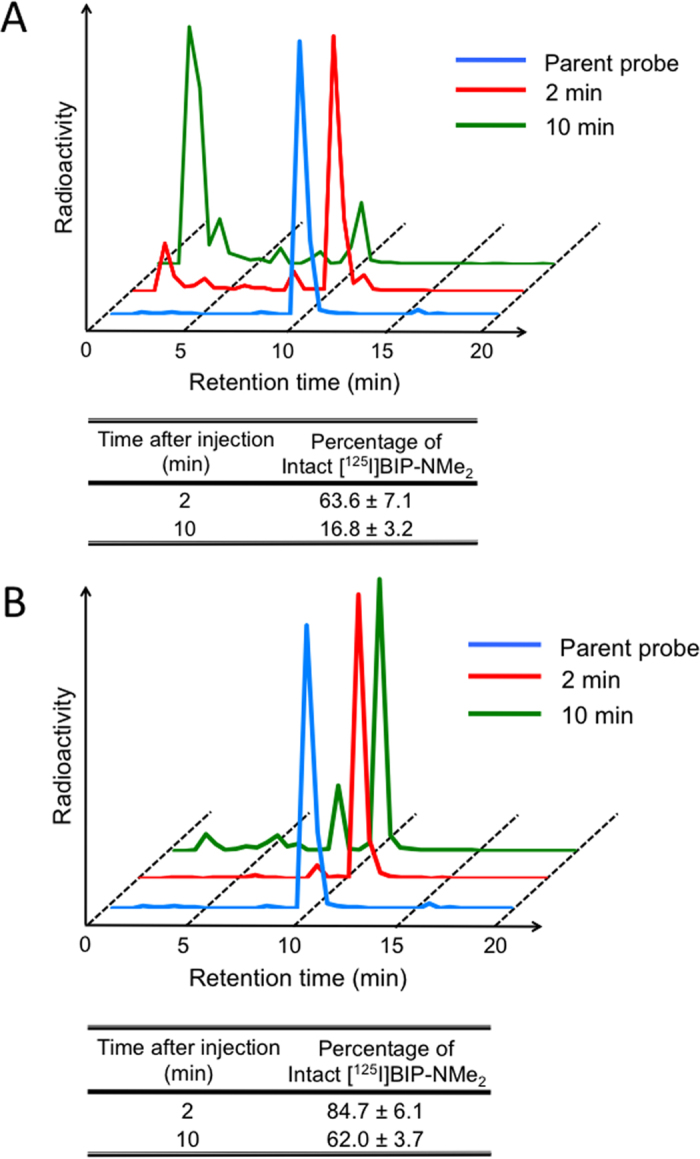
HPLC analysis of radioactivity in the blood (A) and brain (B) after injection of [125I]BIP-NMe2 into mice (n = 4).